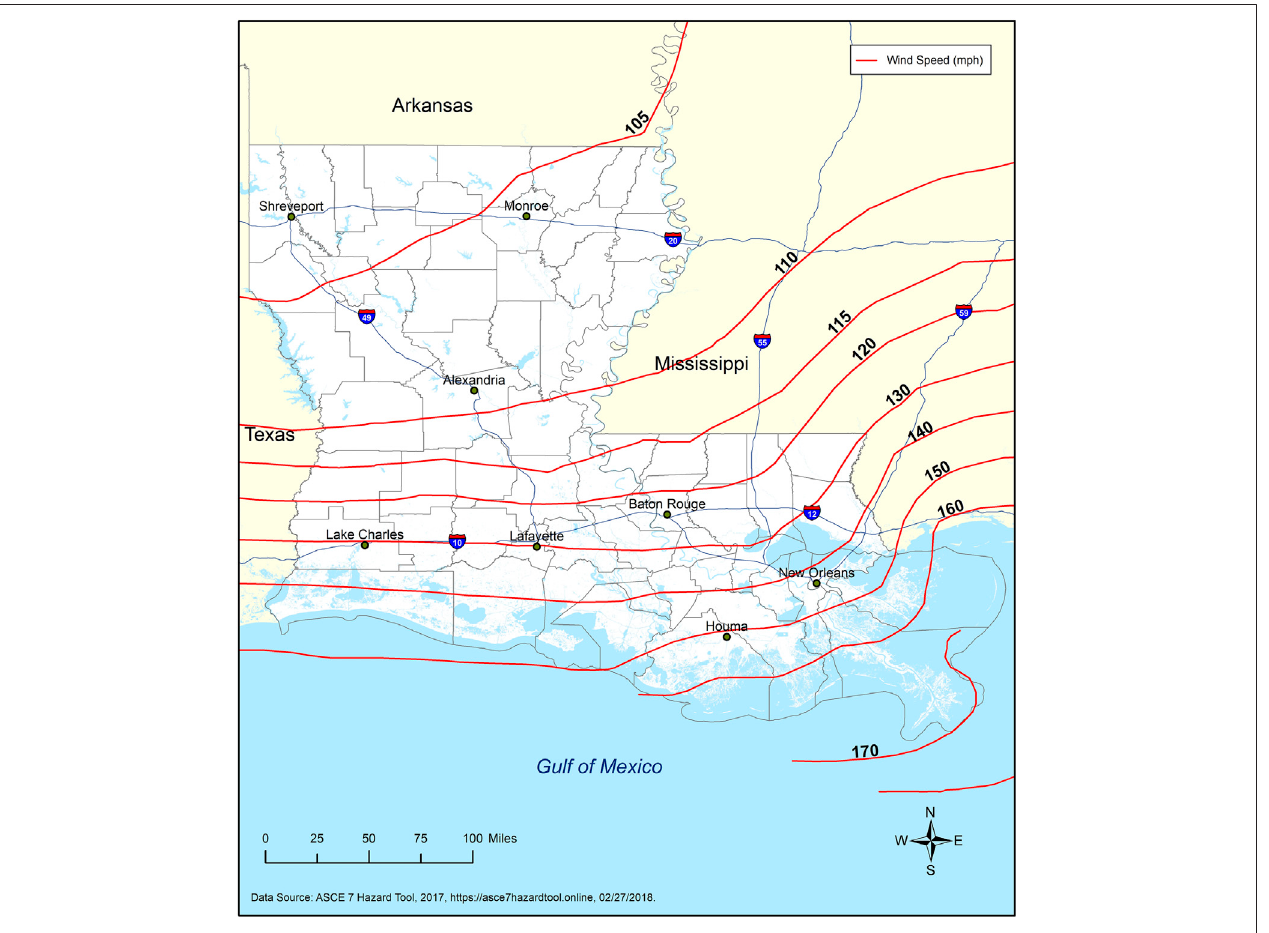
FIGURE 1 | ASCE 7,700-year return period 3-sec gust wind speed (mph) hazard map for Louisiana (GOHSEP, 2019).